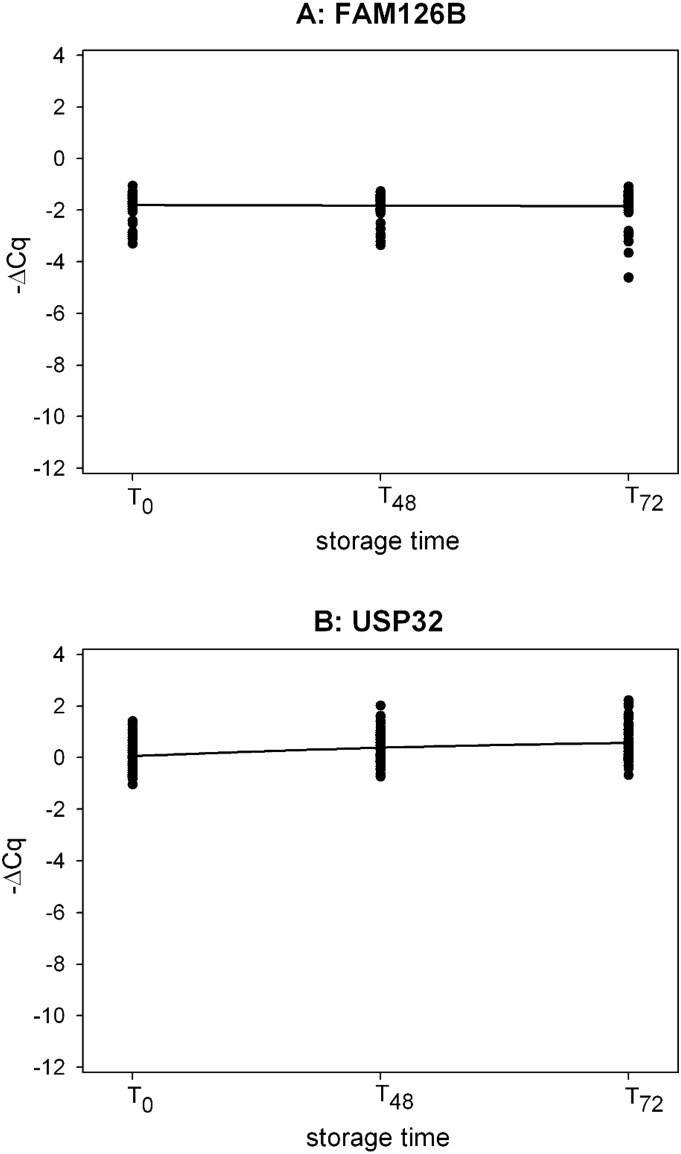
Time-course profile of the PAXgene biomarkers in the validation study.4A: FAM126B (mixed model contrasts: T48 vs T0, p-value = 0.5251; T72 vs T0, p-value = 0.2734) and 4B: USP32 (mixed model contrasts: T48 vs T0, p-value <0.0001;T72 vs T0, p-value<0.0001). ΔCq = (Cqshort assay−Cqmedium assay).